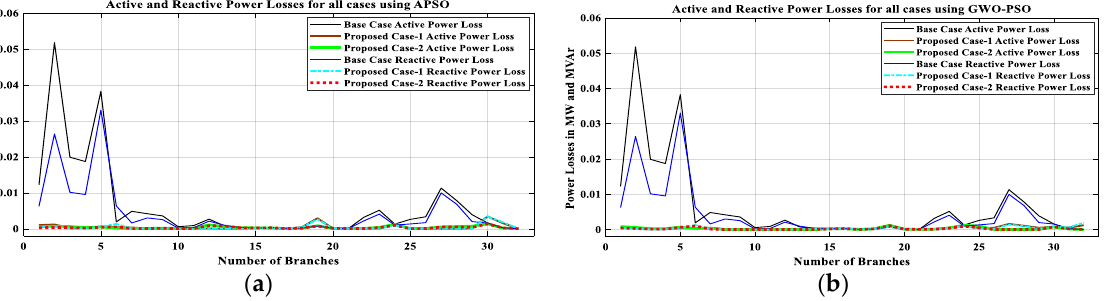
Figure 13. Cumulative representation of active and reactive power loss for all cases of 33-bus RDN; ( a ) APSO, ( b ) GWO-PSO.